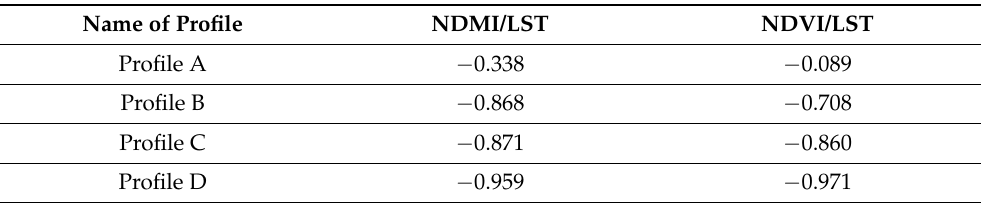
Figure 5. Large-scale map of the distribution of the LSTs in the summer season. The ragged line is the “C”-temperature profile. The values in red are the thermal values of the permafrost-taiga landscapes. Table 3. Pearson correlation coefficient calculated between the values of the vegetation indices NDVI and NDMI (separately) and